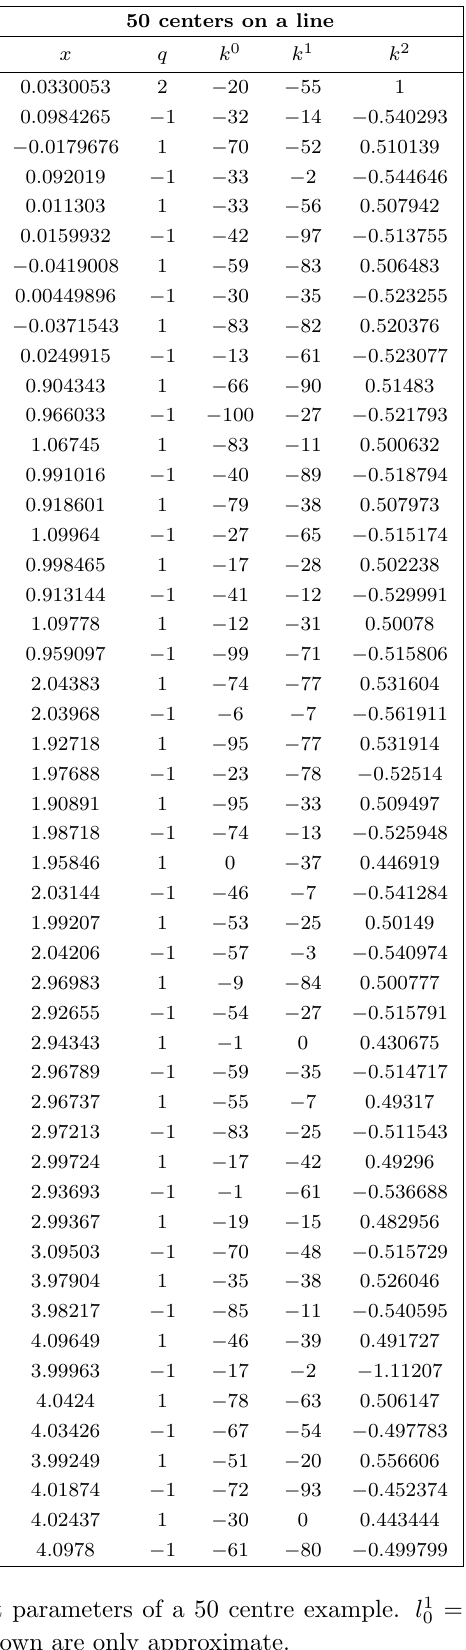
Output parameter values shown are only approximate.